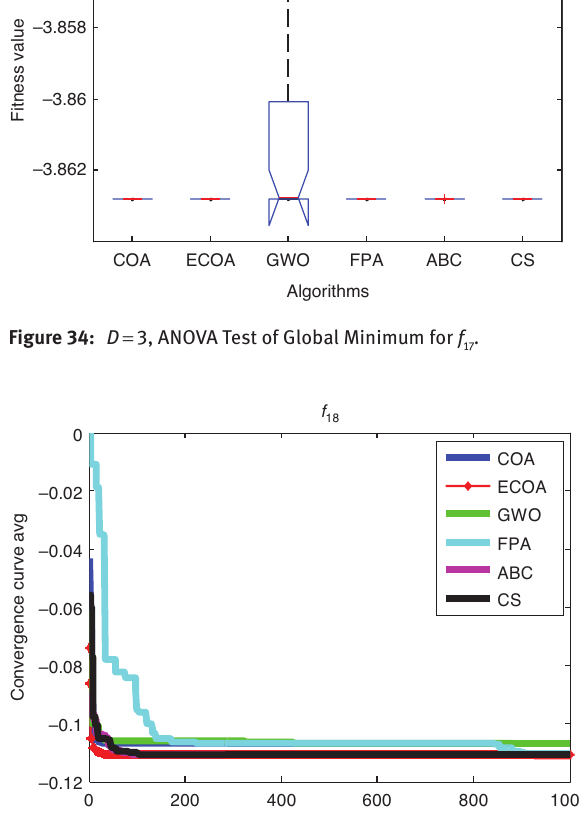
Figure 35: D = 6, Evolution Curves of Fitness Value for f